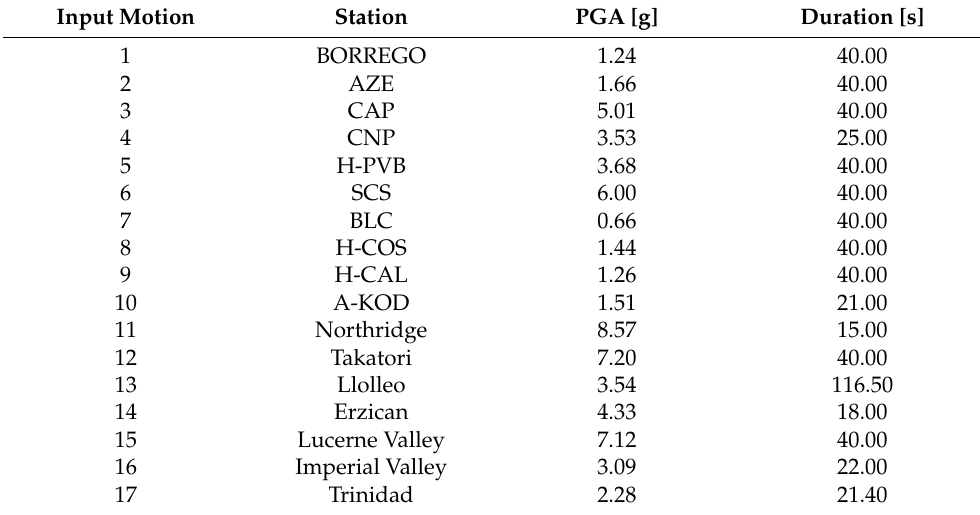
Table 4. Seismic scenario.